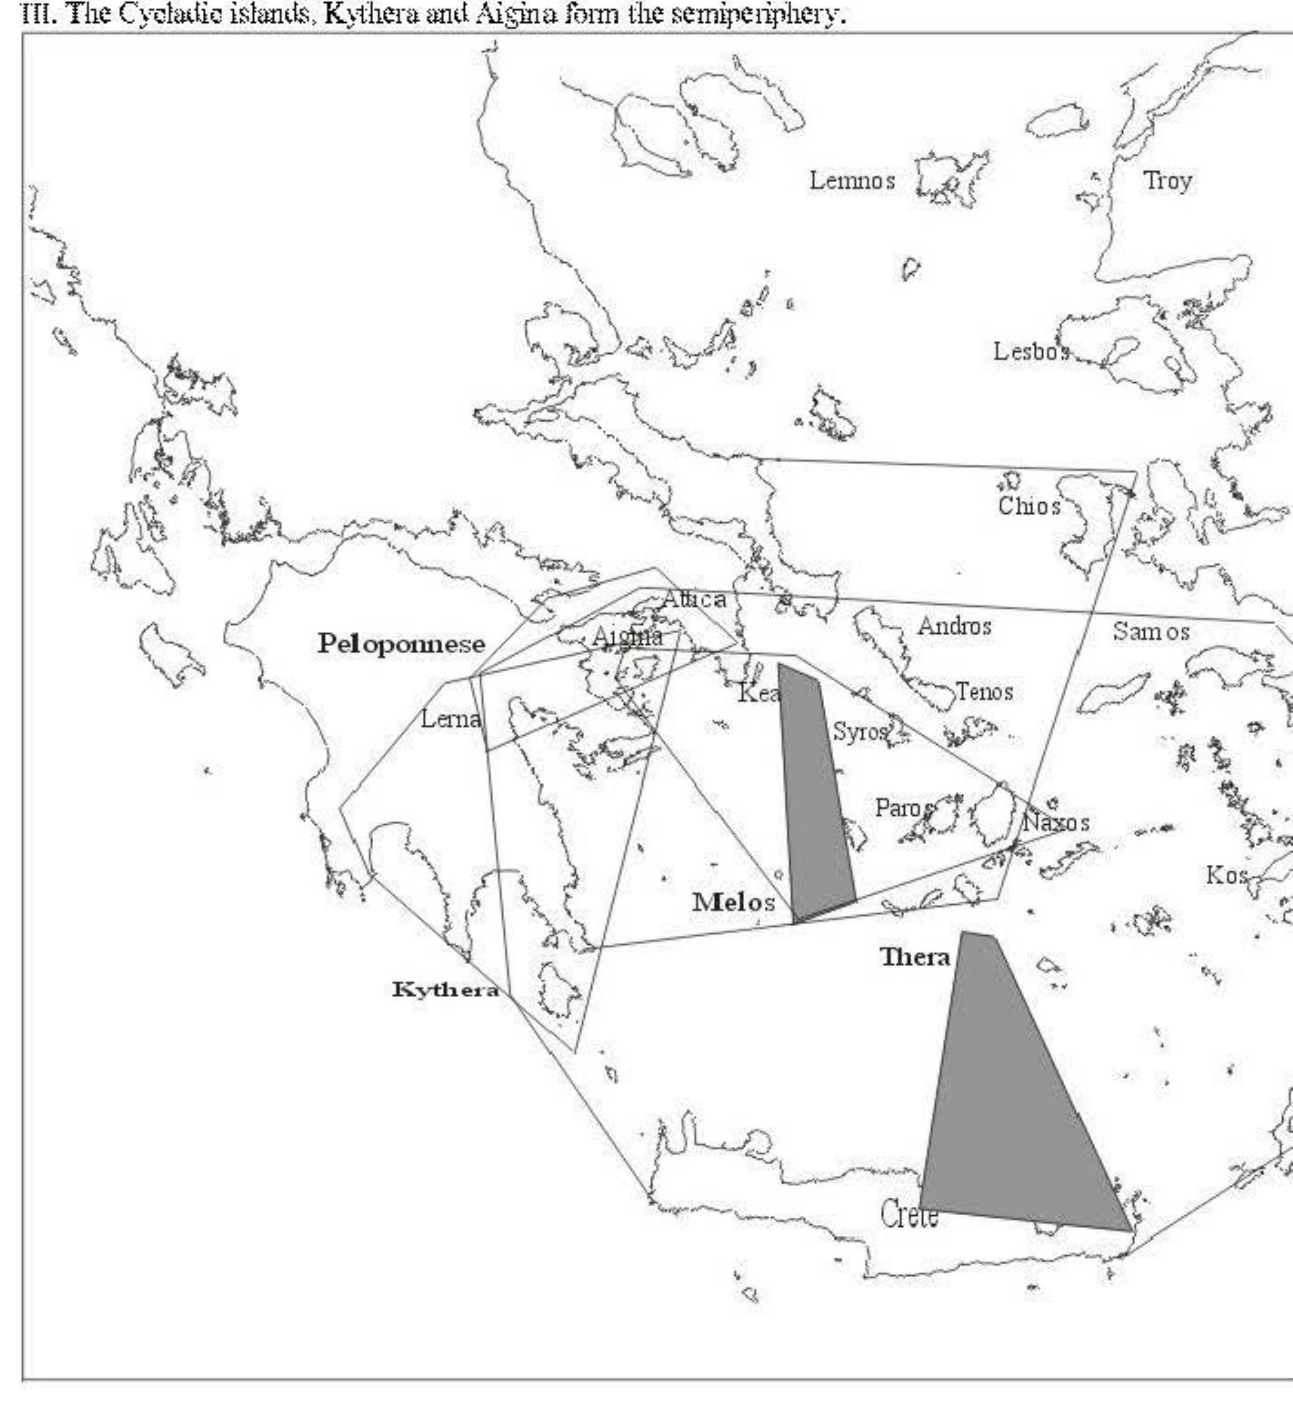
HI. The Cycladic islands. Kythera and Aigi:nu fo1m the semipedphery.